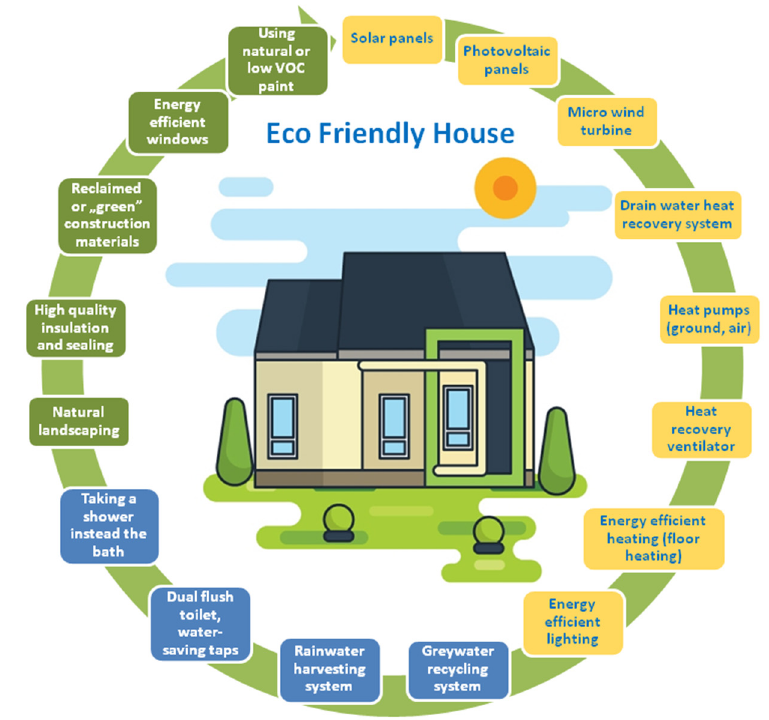
Figure 2. The concept of the analyzed environmentally friendly house.